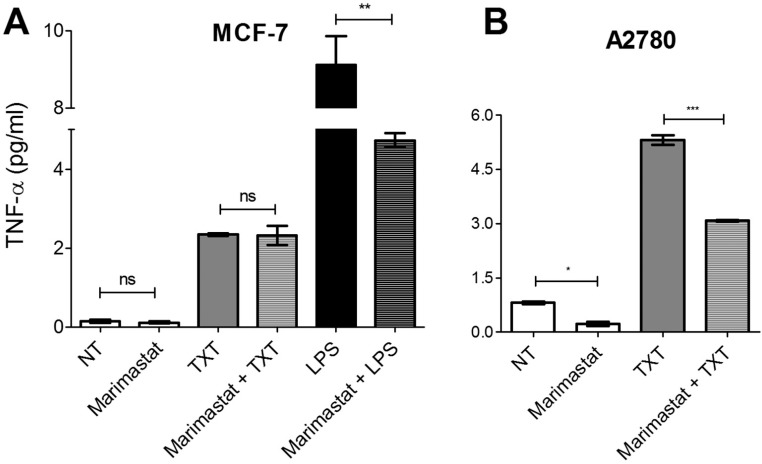
The effect of MMP inhibition by Marimastat on cellular TNF-α levels.MCF-7 and A2780 cells were treated with 2.5 nM docetaxel (TXT) or 10 μg/ml LPS for 72 hours in the presence or absence of 200 nM Marimastat, a broad-spectrum MMP inhibitor. The data represent the mean of three replicates (+/-SEM). The significance of differences in TNF-α levels between treatments was assessed using a two-tailed T-test; *** p<0.0001, ** p<0.001, *p<0.01.